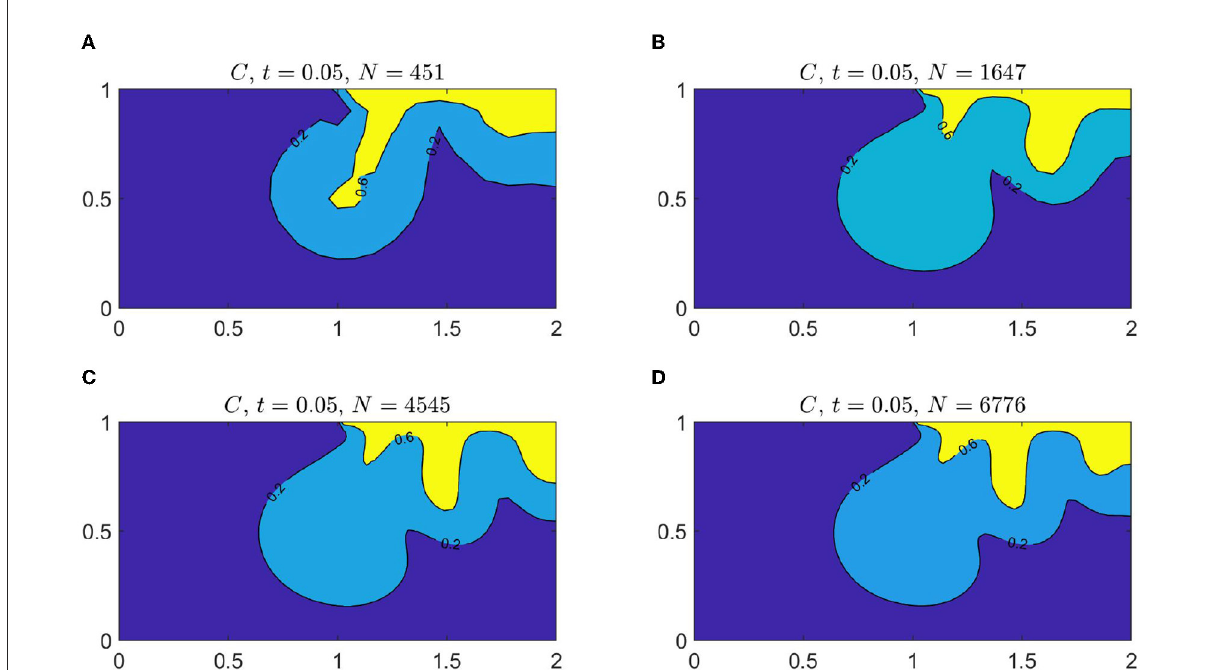
FIGURE17 Isochlor C = 0.2 and C = 0.6 for different number of total nodes. (A) N = 41 × 11 = 451, (B) N = 61 × 27 = 1,647, (C) N = 101 × 45 = 4,545, and (D) N = 121 × 56 =